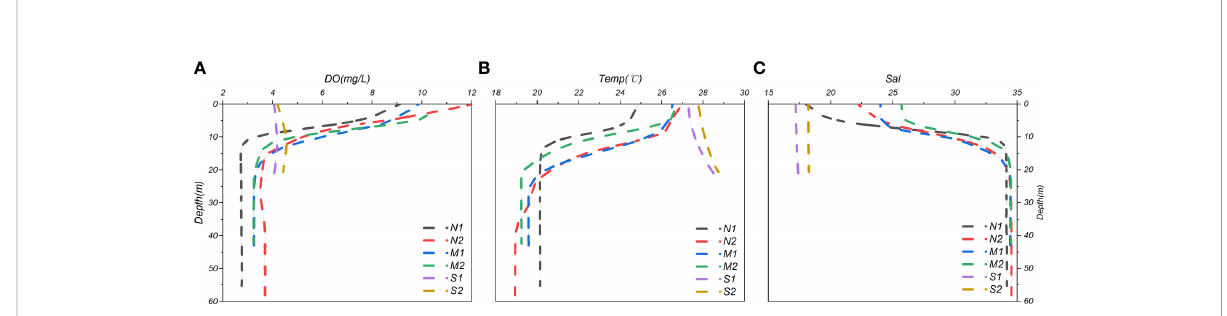
FIGURE 6 Vertical pro fi les of DO (A) , temperature (B) and salinity (C) in different